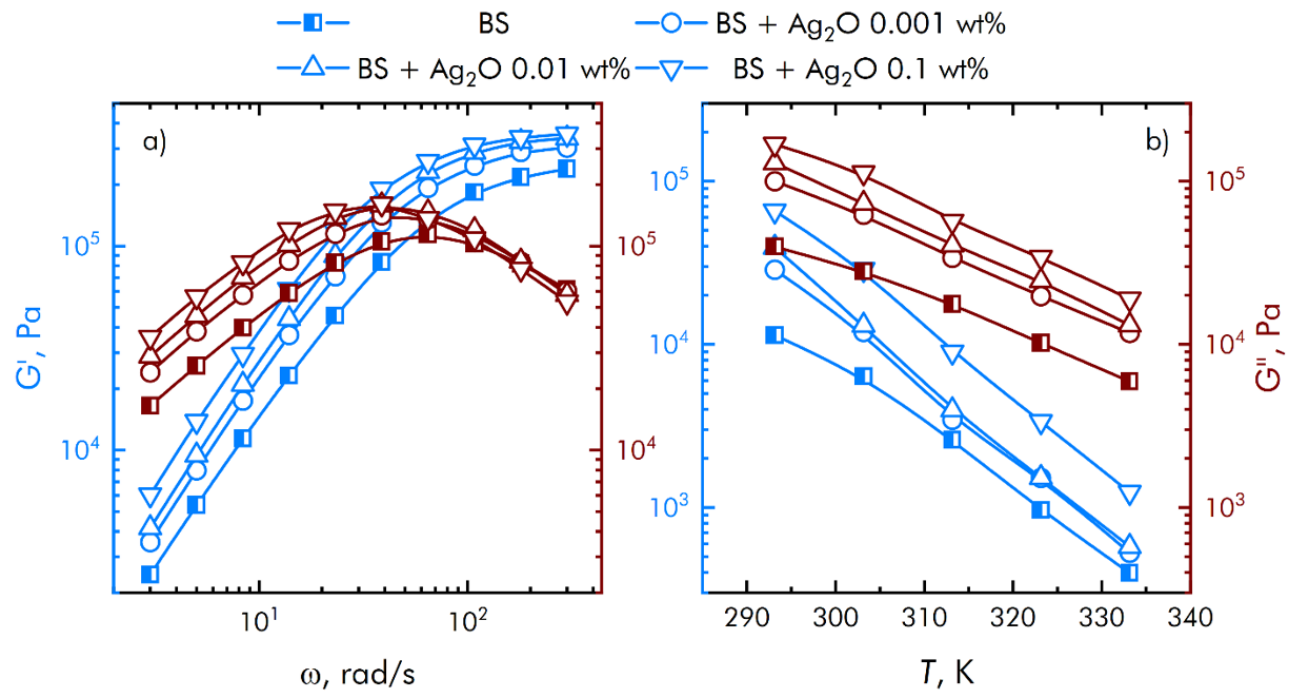
Figure 5. Frequency ( a ) and temperature ( b ) dependences of viscoelastic properties of the resulting compositions.